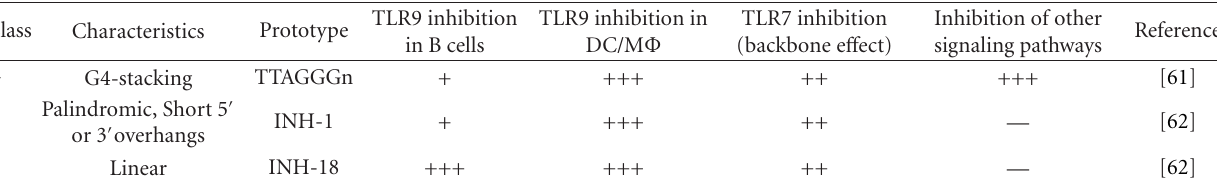
Table 2: Classification of inhibitory